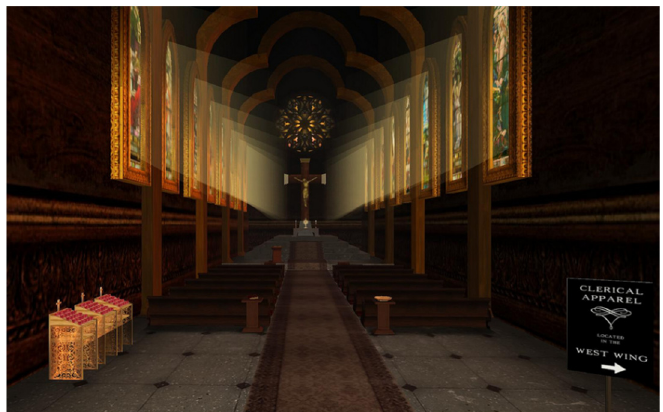
Figure 2. Basilica Cardinale Source by (Rafeejewell 2009).